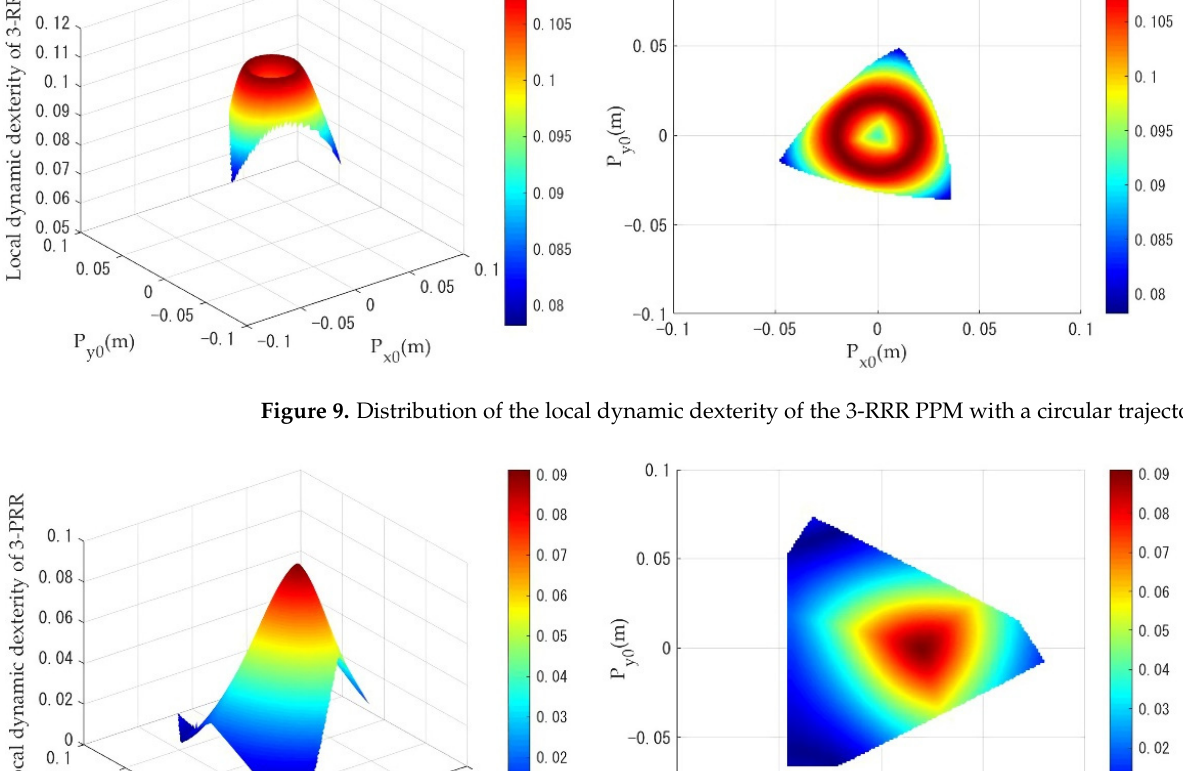
Figure 11. Distribution of the local dynamic dexterity of the 3-RPR PPM with a circular trajectory.